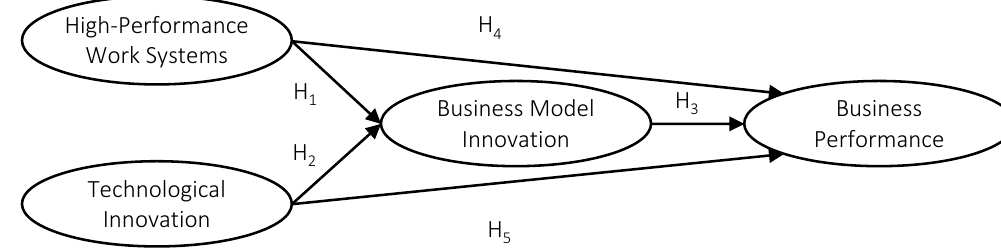
Figure 1. Research